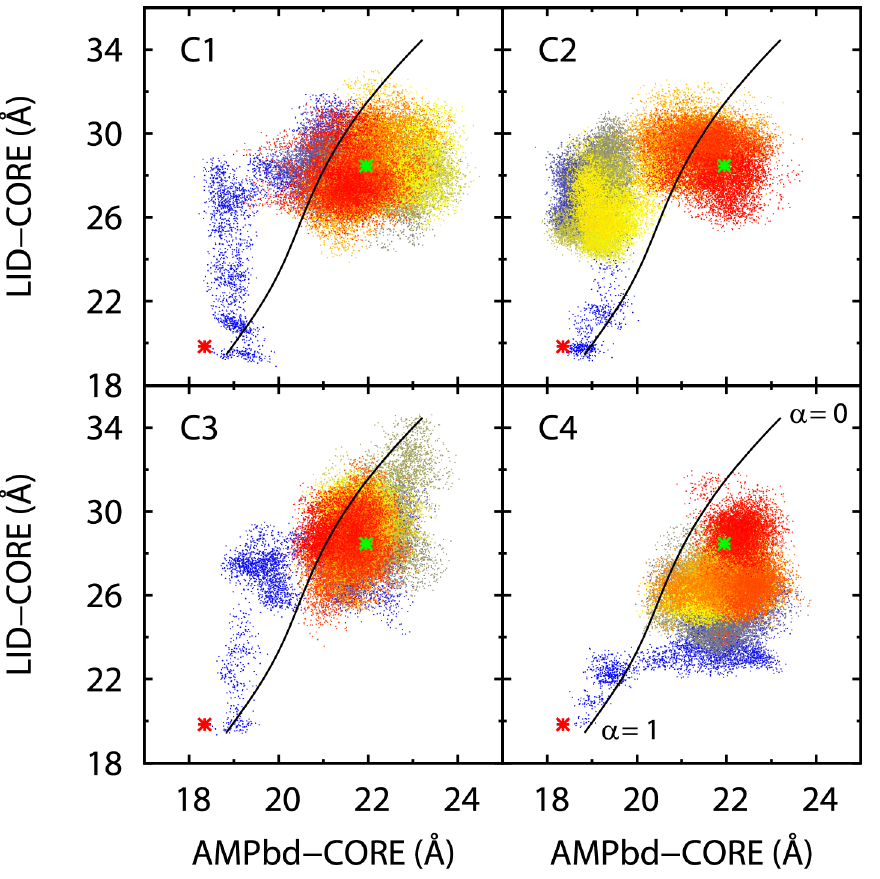
Figure 3. Evolution of the distances between the domain centers. The center of each (CORE, AMPbd, or LID) domain is defined by the average position of its C a atoms. Distances between these centers are calculated for four 100-ns unrestrained simulations (C1–C4). Each frame in the simulation trajectories corresponds to one point in the figure, with the color denoting the progression of the simulation, from blue at the onset (via yellow) to red at the end of the simulation. The black curve represents a pathway averaged from all unrestrained simulations (see Methods) and used as the principal curve in the umbrella-sampling simulations. The green and red stars indicate the positions of the open and closed crystal structures, respectively.